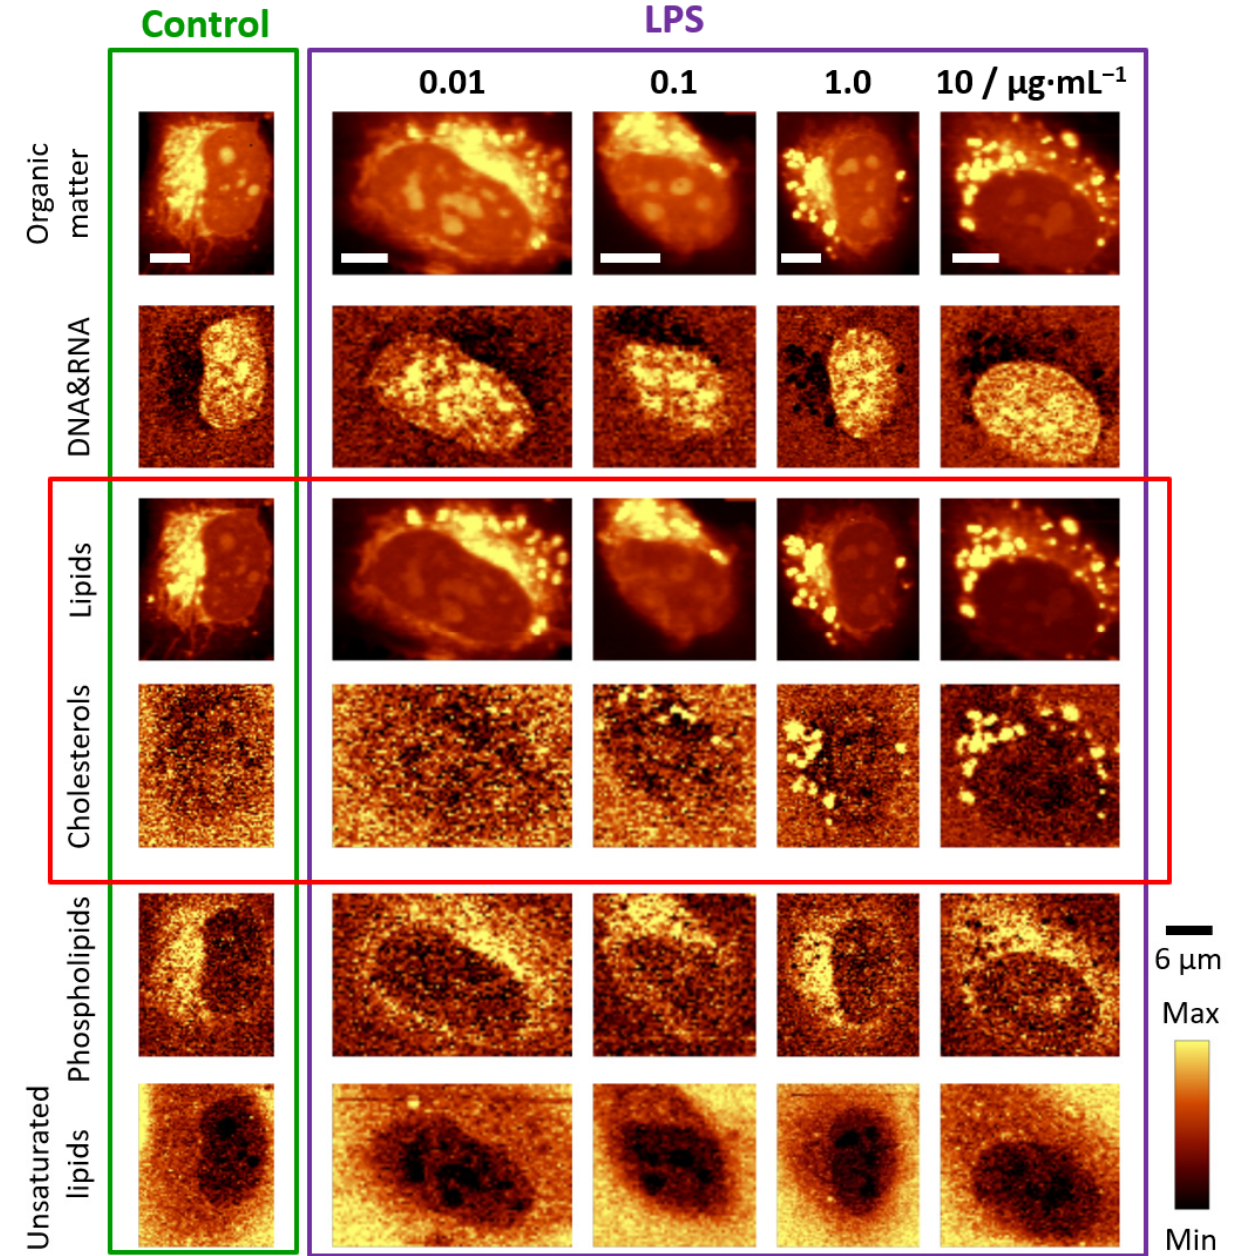
Figure 1. Representative Raman images of endothelial cells: control and incubated with LPS for 24 h. Raman images of distribution in HMEC-1 obtained by integration in the following spectral regions: 3030–2830 cm − 1 (organic matter), 810 − 760 cm − 1 (DNA & RNA), 2900–2830 cm − 1 (lipids), 715–695 cm − 1 (cholesterols), 733–713 cm − 1 (phospholipids) and 3030–3000 cm − 1 (unsaturated lipids). Scale bars equal 6 μ m.